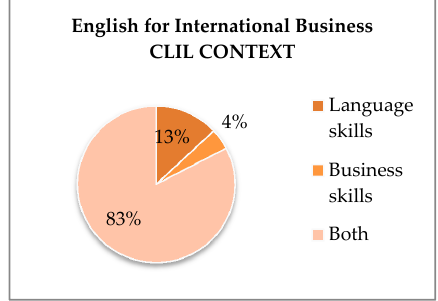
Figure 3. Business students’ expectations towards the skills to develop in their ESP course.